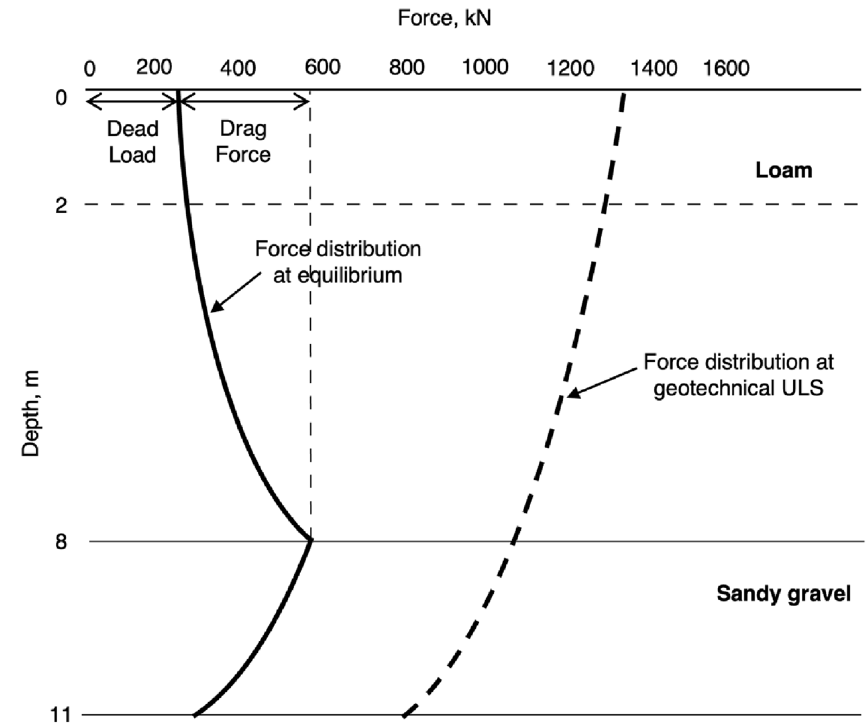
Fig. 3 Pile force distribution at equilibrium and geotechnical ULS for Case II